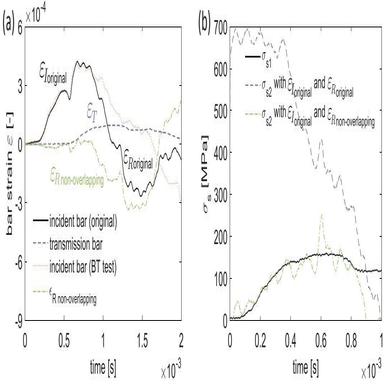
Bar strain wave group of an STPB UNTS test (a) and dynamic stress equilibrium check (b).